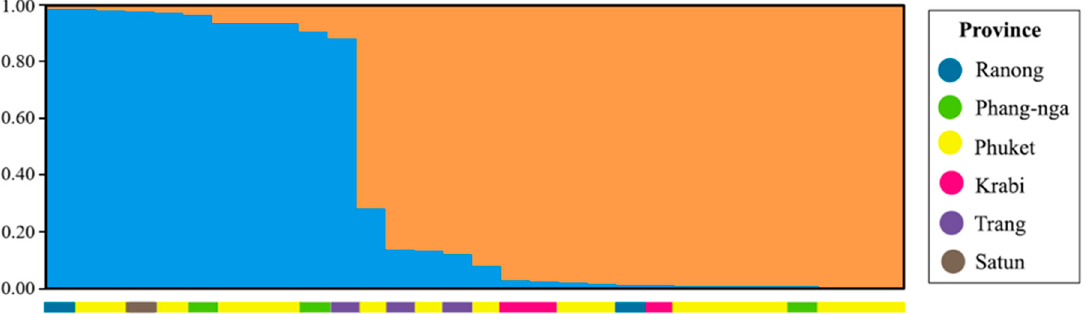
Figure 2. Population structure plot for 11 microsatellite loci of T. aduncus from the Thai Andaman Sea. The population structure consisted of two genetic clusters (K = 2) indicated by different colors (blue and orange). Each individual is represented by a single vertical stripe divided into K color segments, of which K is the assumed number of ancestral groups.